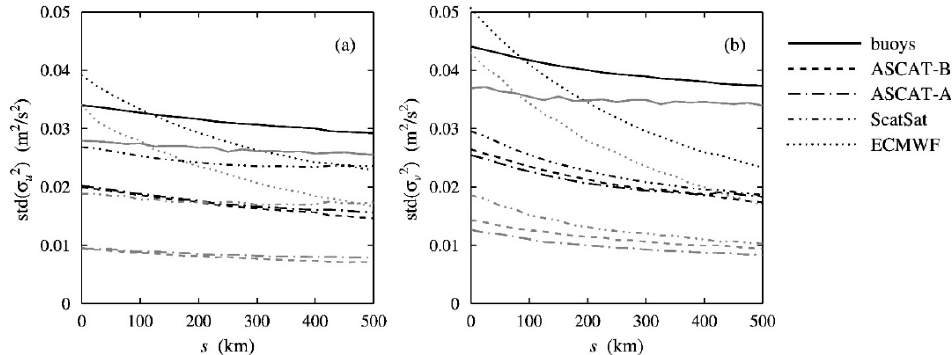
Figure 4. Accuracy of the model average (black curves) and the least-squares solution (gray curves) for the observation error variances in u ( a ) and those in v ( b